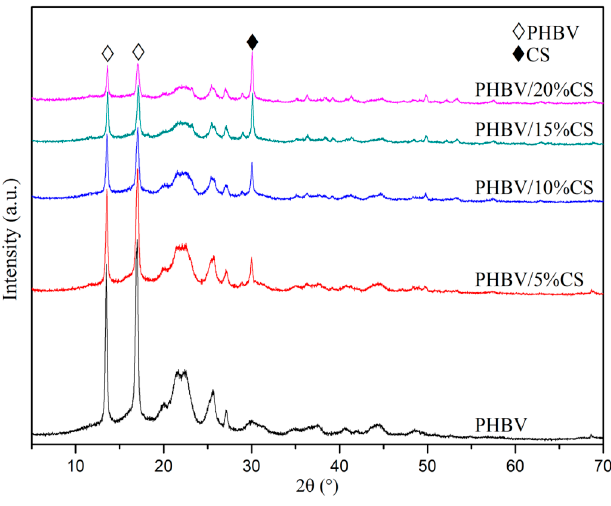
Figure 3. XRD patterns of the SLS-fabricated scaffolds of different formulations.